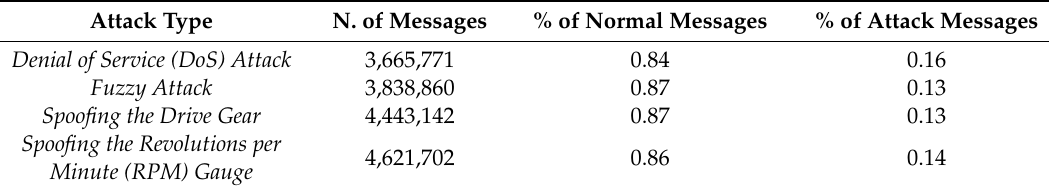
Table 1. Car hacking data type and size.